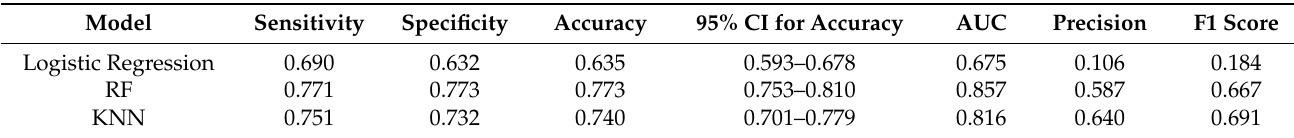
Table 2. Performance of depression risk prediction.